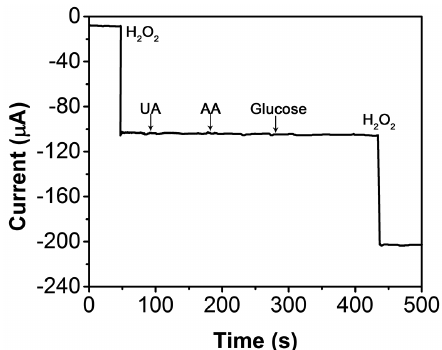
O to PBS. Measured at ─0.39 V. Inset: 2 2 O concentration. 2 2